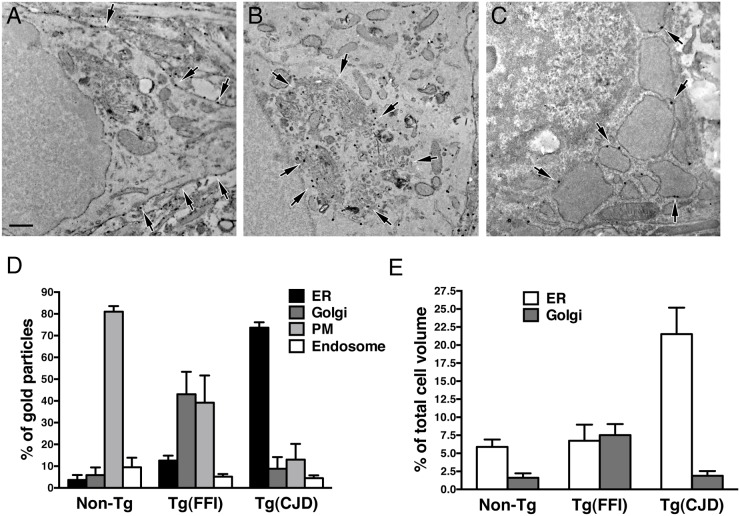
Tg(FFI) and Tg(CJD) neurons show different intracellular PrP accumulations and morphological abnormalities of transport organelles.Cultures of cerebellar granule neurons from non-Tg/Prnp
+/+, Tg(FFI-K5+/-)/Prnp
0/0 and Tg(CJD-A21+/-)/Prnp
0/0 mice were fixed and labeled with anti-PrP monoclonal antibody 12B2 using the gold-enhance protocol. WT PrP is mostly found at the plasma membrane (A). D177N/M128 PrP is mostly in the Golgi (B), and D177N/V128 PrP is mostly in the ER, whose cisternae appear enlarged and swollen (C). Scale bar = 250 nm in A, B and C. (D) Quantification of gold particles in different cell compartments. PM, plasma membrane. (E) Quantification of ER and Golgi volumes of cultured cerebellar granule neurons. Data are the mean ± SD of at least 10 cells per specimen. Data for non-Tg/Prnp
+/+ and Tg(CJD-A21+/-) neurons in D and E are from [14].